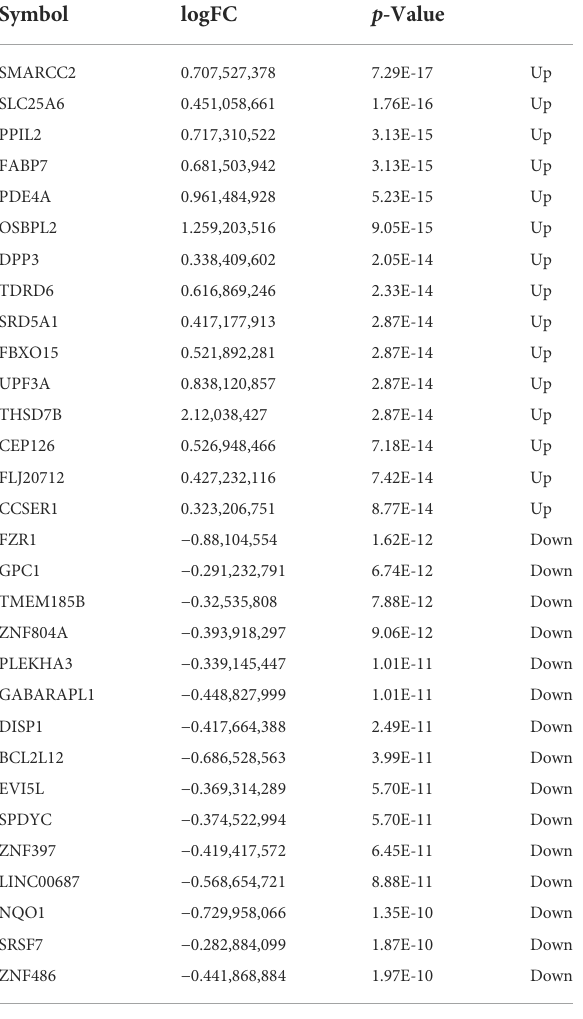
TABLE 2 Top 30 DEGs in preeclampsia human placenta tissues (GSE75010).